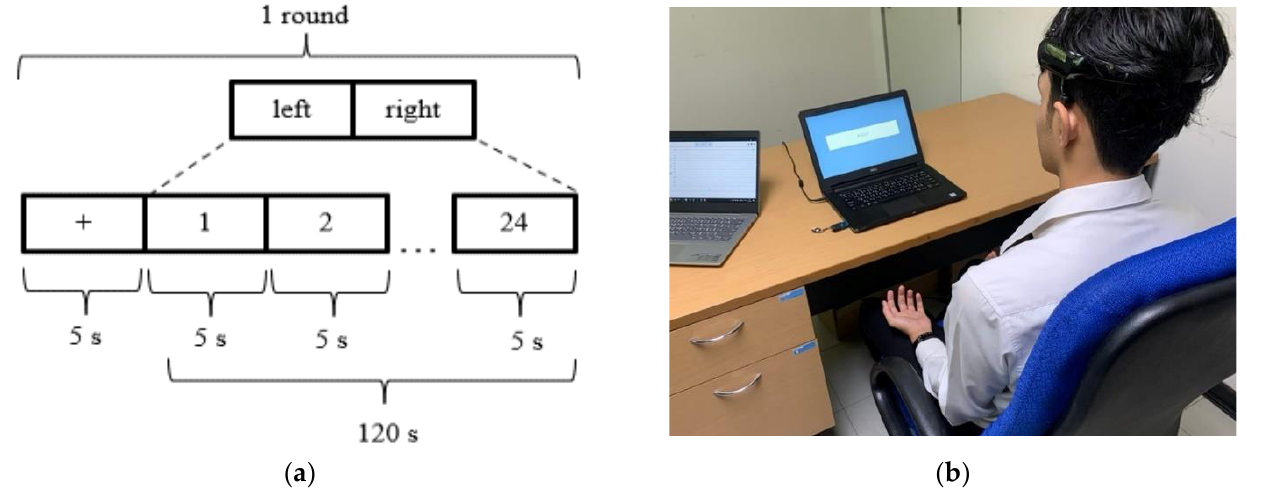
Figure 4. ( a ) Task experiment for motor imagery via upper and lower limb movement paradigms; ( b ) the experimental setup.